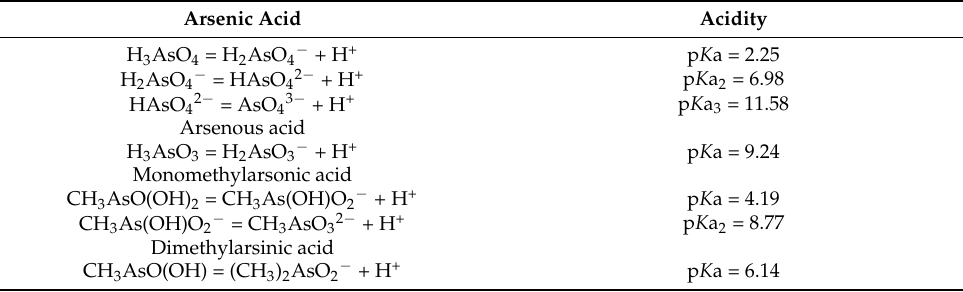
Table 2. Aqueous speciation of arsenic